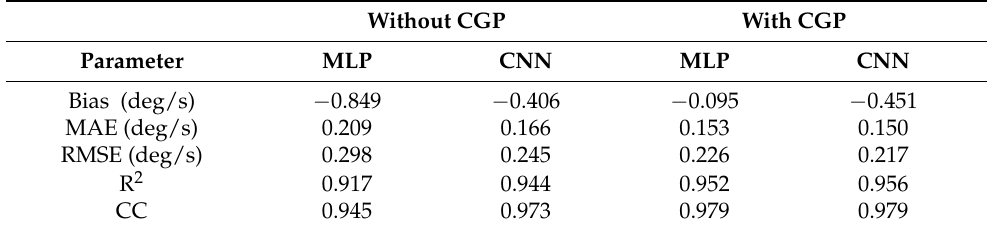
Table 4. Models normalized statistical results comparison.